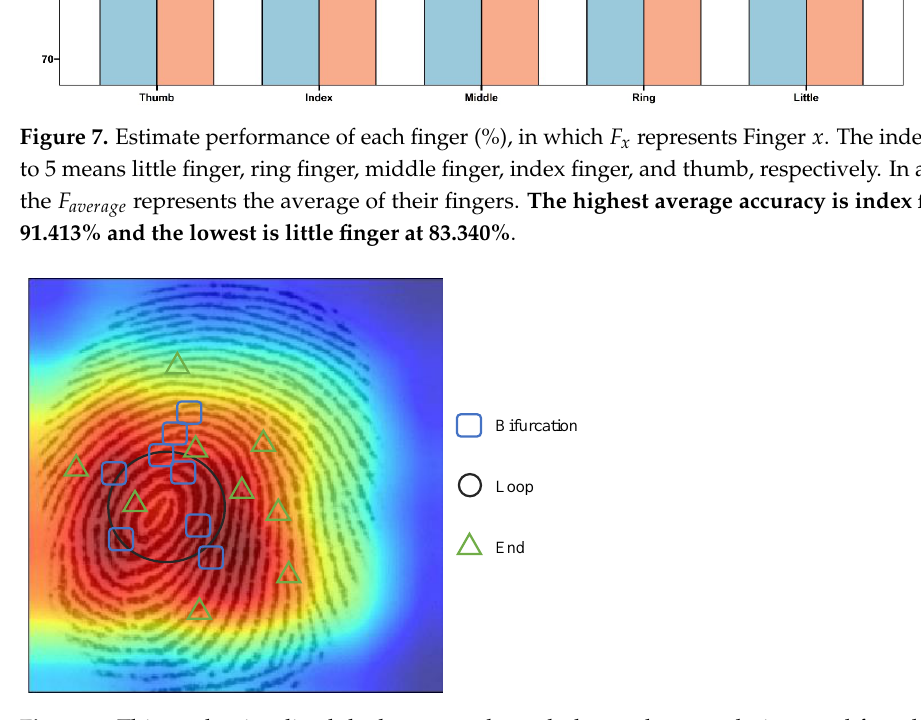
Figure 8. This study visualized the heat map through the grad-cam technique and found that the concentration was mainly on or around the center of the fingerprint, with the concentration area tending to be more of a continuous section, and it can be said that the basis of recognition is the complete ridge feature, thus, also confirming the reason for the manual extraction of features and also validating the interpretability of this